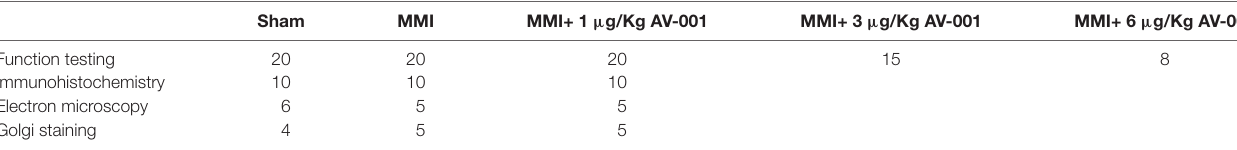
TABLE 1 | Rats were sacrificed at 6 weeks after MMI and the number of animals used for various analysis is